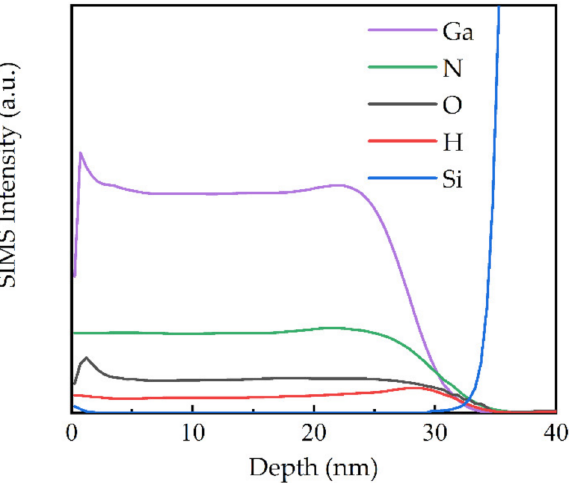
Figure 11. SIMS depth profiles of Ga, N, O, H, and Si intensities for the GaN film deposited at 350 ◦